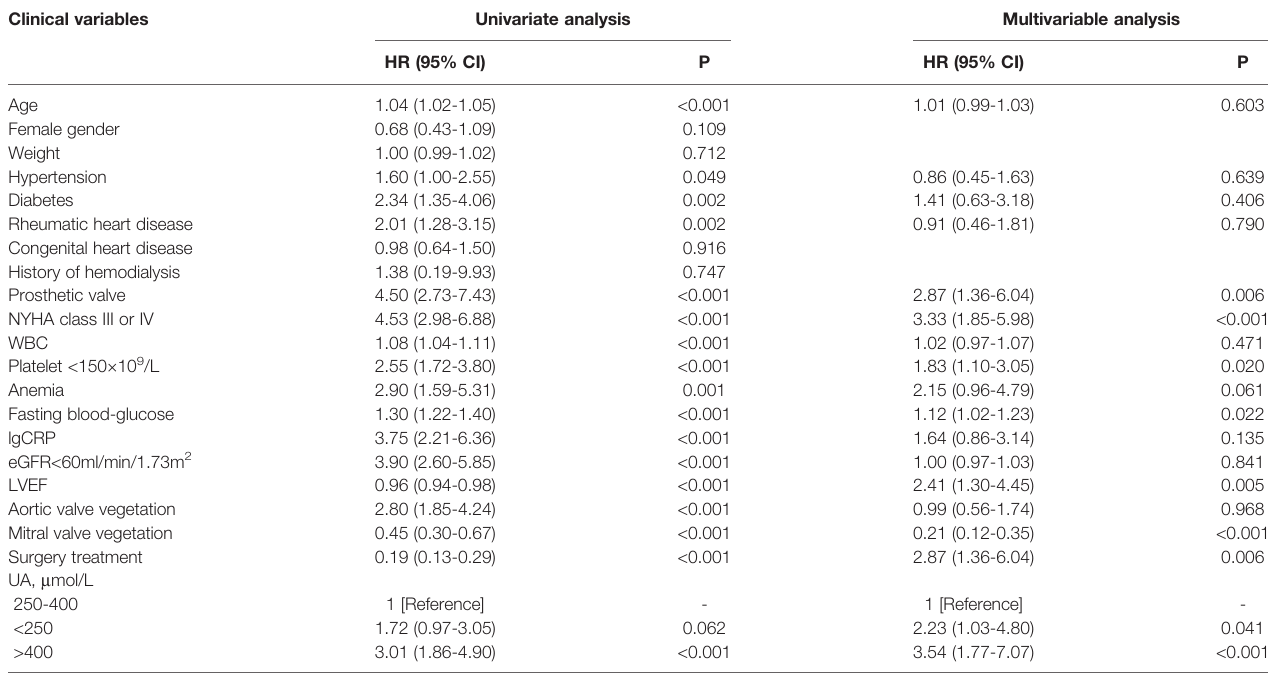
TABLE 3 | Univariate and multivariable Cox regression analysis for 6-month mortality. Clinical